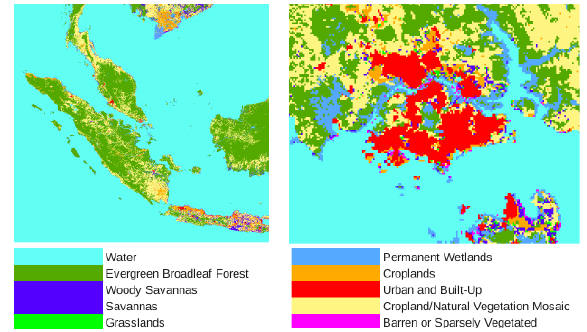
Figure 2. Dominant land use categories in the MODIS 500 m res- olution data. The left and right figures correspond to the innermost (d01) and outermost (d04) computational domain,